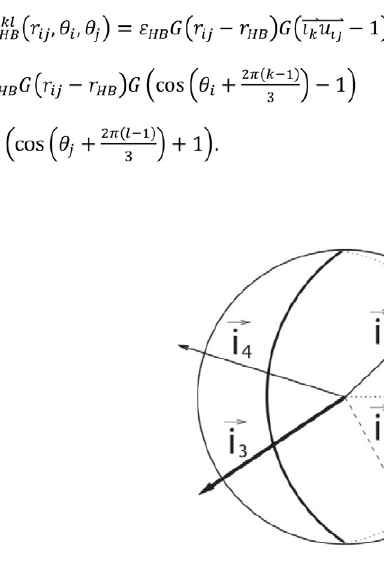
Figure 2: The MB particles in